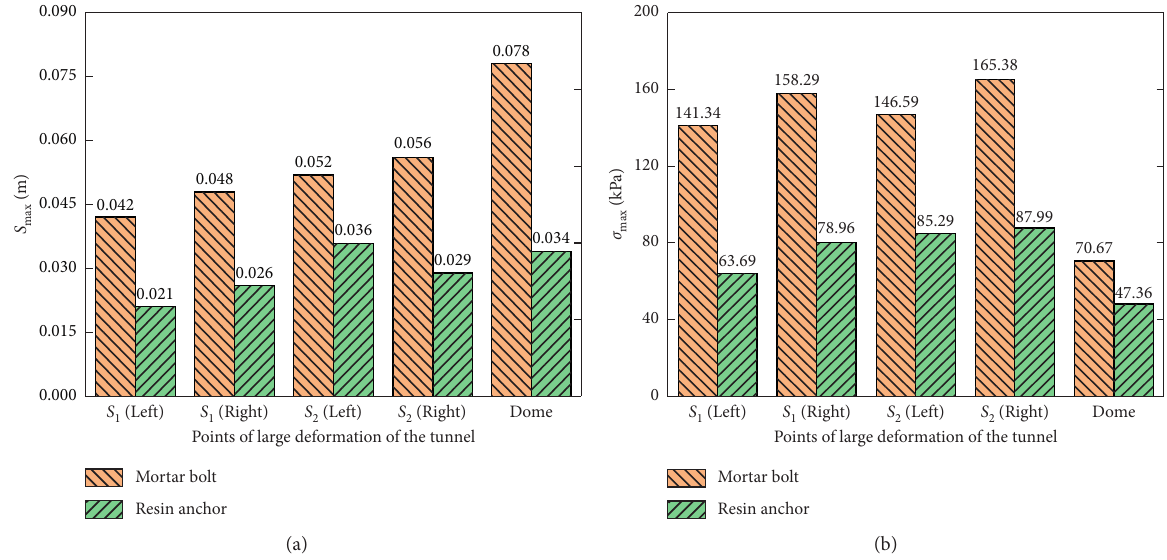
Figure 10: The length of mortar bolt and resin bolt support is 6.0m: (a) S